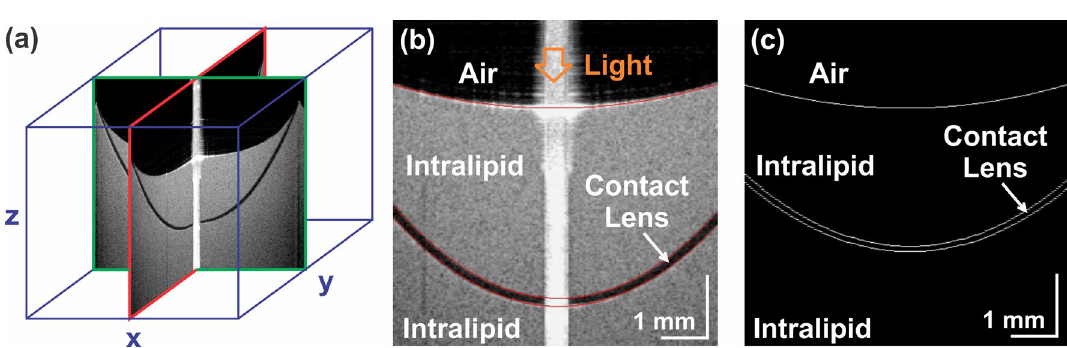
Figure 2. OCT data processing. ( a ) Central cross-sections were extracted from a three-dimensional data set. The lens was then placed in a solution of increased reflectivity. ( b ) The intralipid interface and lens surfaces were segmented (red). ( c ) The images were corrected for light refraction, and profilometric parameters of the lens were